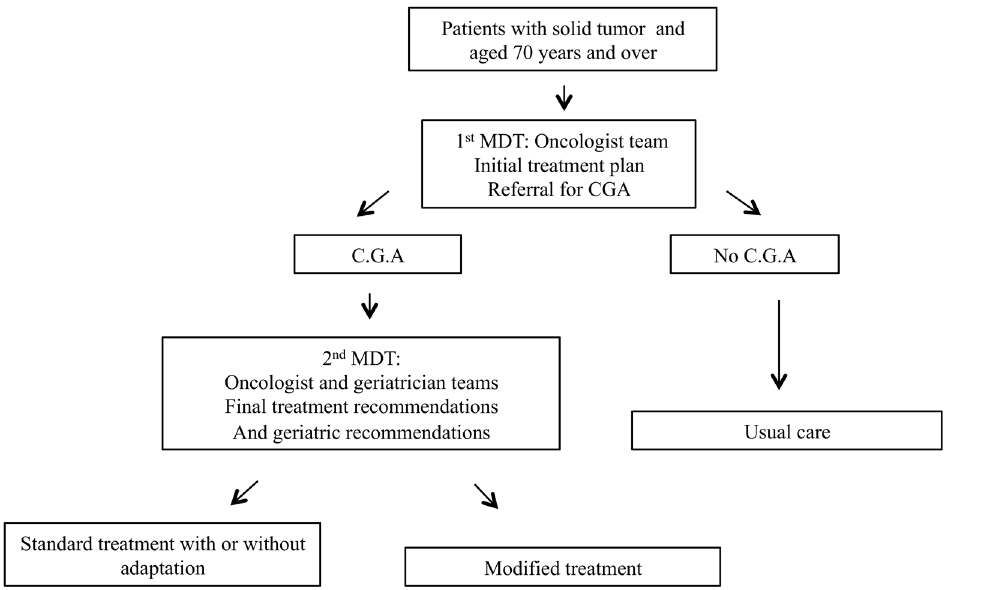
Fig 1. Patients seen in oncogeriatric clinics.